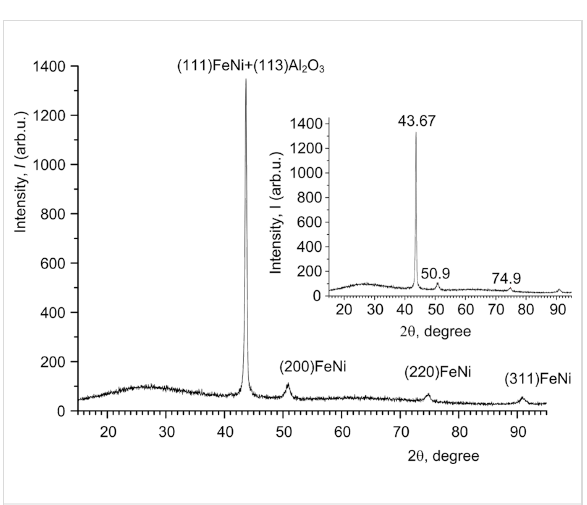
Figure 5: XRD pattern of Ni–Fe NWs inside the alumina template with H PA of 50 μ m and a current density 3 mA·cm − 2 , deposition duration 90 min.